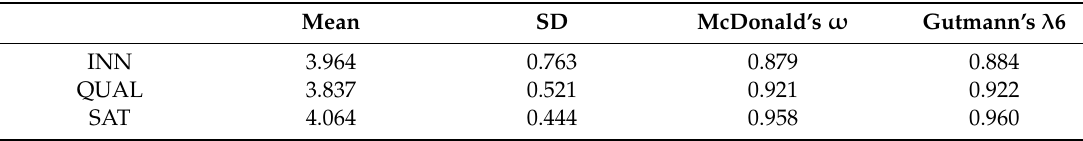
Table 4. Scale reliability statistics.